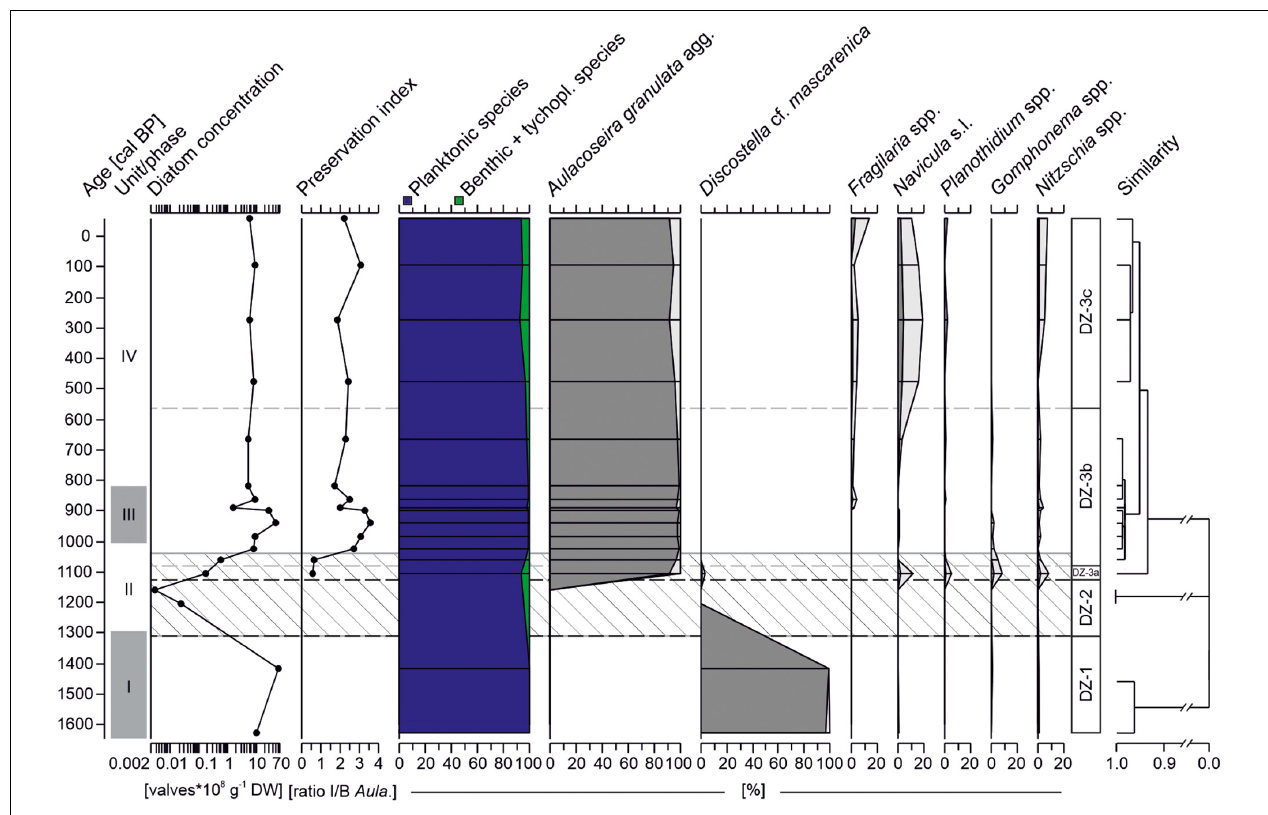
FIGURE 7 | Diatom record from core AMP 16-2 retrieved from Lake Amparihibe plotted on an age scale with relative abundances taxa ( > 1%), diatom concentration (DW: dry weight), preservation index (ratio intact to broken valves of Aulacoseira granulata ) and abundances of benthic + tychoplanktonic and planktonic taxa. Samples with less than 15 valves counted were excluded from abundance plots. Diatom zone (DZ) indicated by dashed lines were identified by a hierarchical cluster analysis. The lighter colored diatom curves correspond to exaggerated curves by a factor 5. Hatched area indicates zone of lowest diatom concentration and poorer valve preservation. Gray shaded areas on the left demarcate sedimentological units (I to